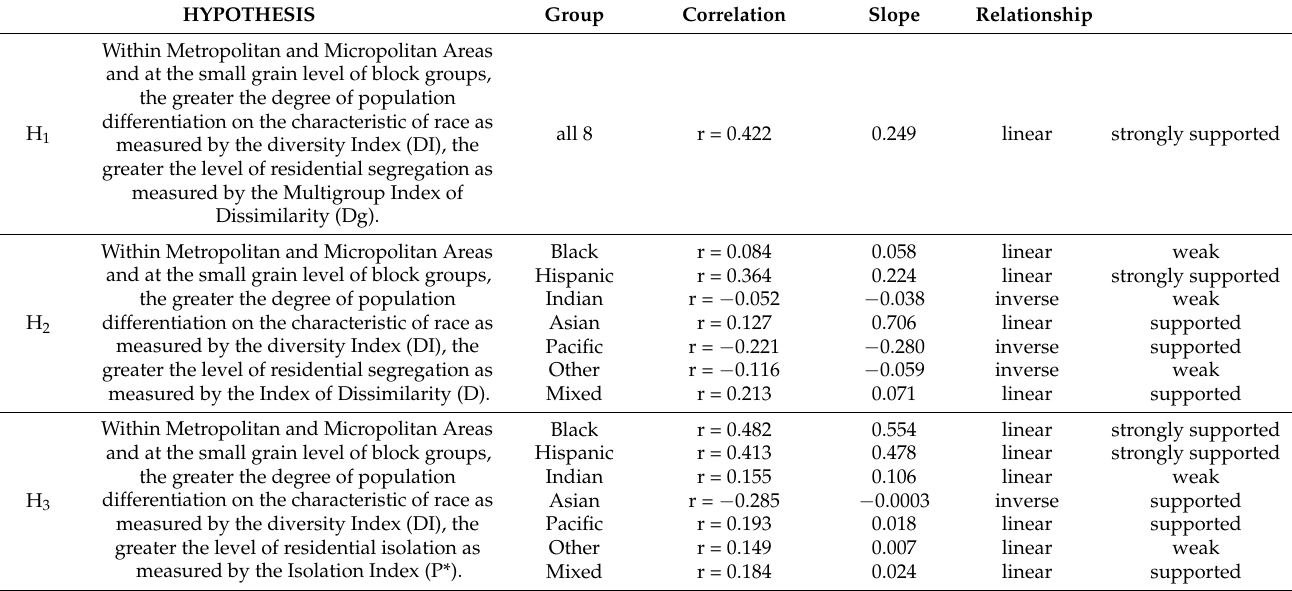
Table 9. The Hypothesis and Related